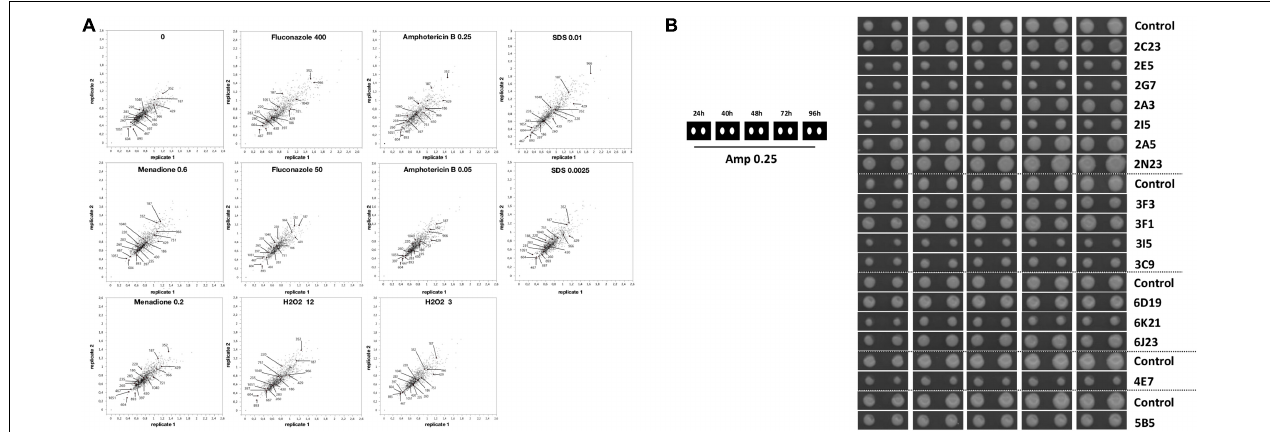
FIGURE 4 | The gene library transformants had different growth phenotypes. (A) Relative colony size of two replicates of 1080 gene library transformants of the RNAi-capable strain under different conditions estimated at 48 h of incubation. Colony size of transformants with the library was normalized to the control (Y1662 with empty vector, which was set to 1.0) on each plate. Conditions: 0 (no treatment), antifungals (fluconazole [50 and 400 µ g/ml], amphotericin B [0.05 and 0.25 µ g/ml]), ROS-generating compounds (hydrogen peroxide [3 and 12 mM], menadione [0.02 and 0.06 mM]), and surfactant (SDS, 0.0025 and 0.01%). (B) Growth for 96 h of transformants (two replicates each) selected for sequencing on the medium with AmB (0.25 µ